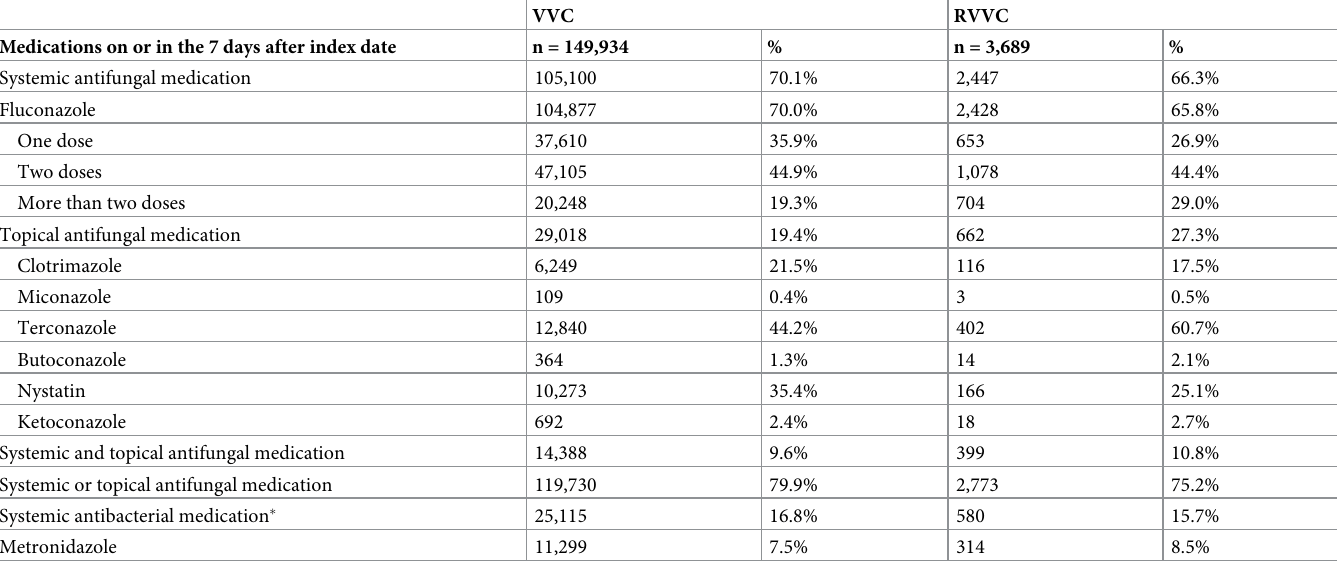
Table 4. Antibacterial and antifungal treatment among patients with vulvovaginal